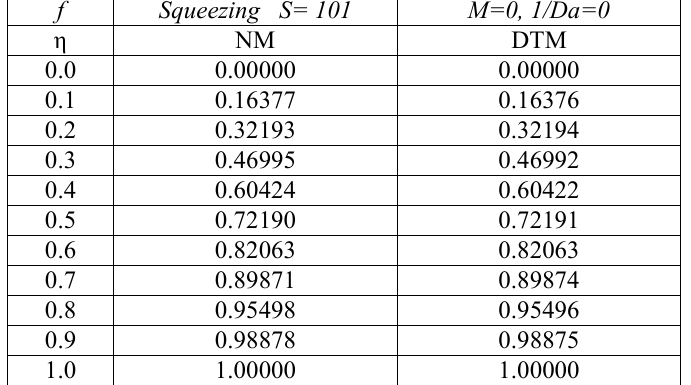
Results of NM and DTM for large squeezing number in the absence of magnetic